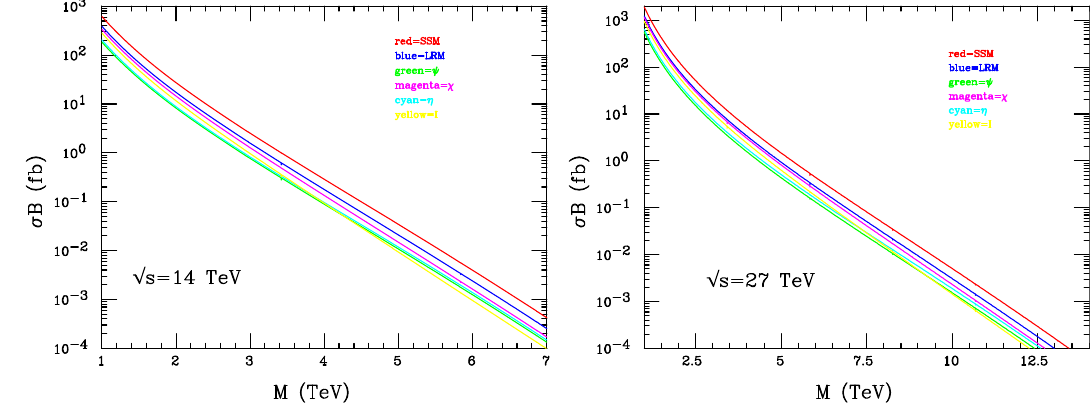
√ s = 14TeV LHC as functions of the Z (cid:2) mass: SSM(red), LRM (blue), ψ (green), χ √ s = 27TeV √ s = 14TeV with L =